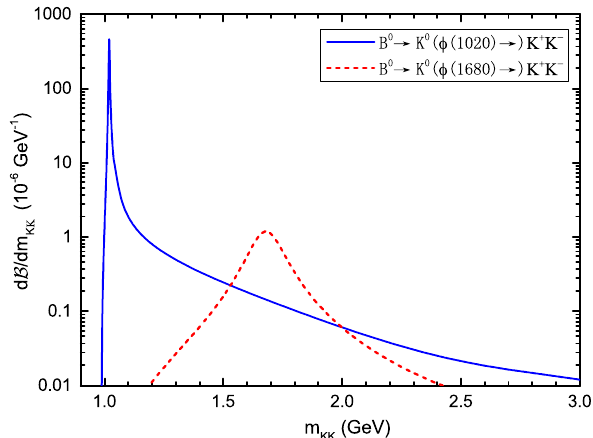
Fig. 2 Differential branching fractions from the threshold of K + K − to 3 GeV for the B 0 → φ( 1020 ) K 0 → K + K − K 0 and B 0 → φ( 1680 ) K 0 → K + K − K 0